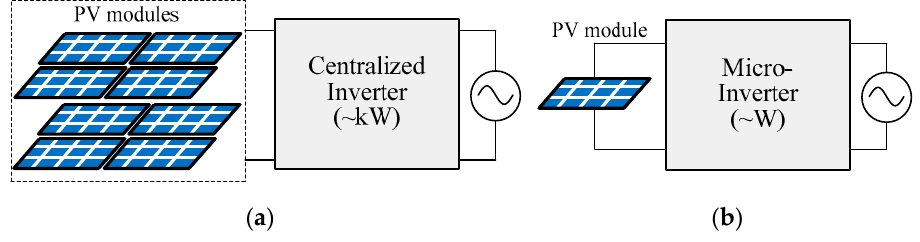
Figure 1. Configuration of PV power generative system. ( a ) Centralized inverter and ( b ) micro-inverter.